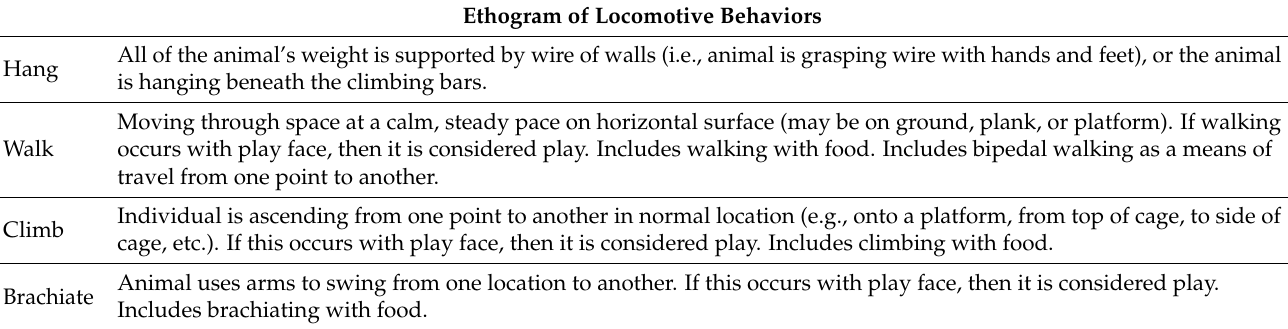
Table 1. Ethogram of locomotive behaviors. Ethogram of Locomotive